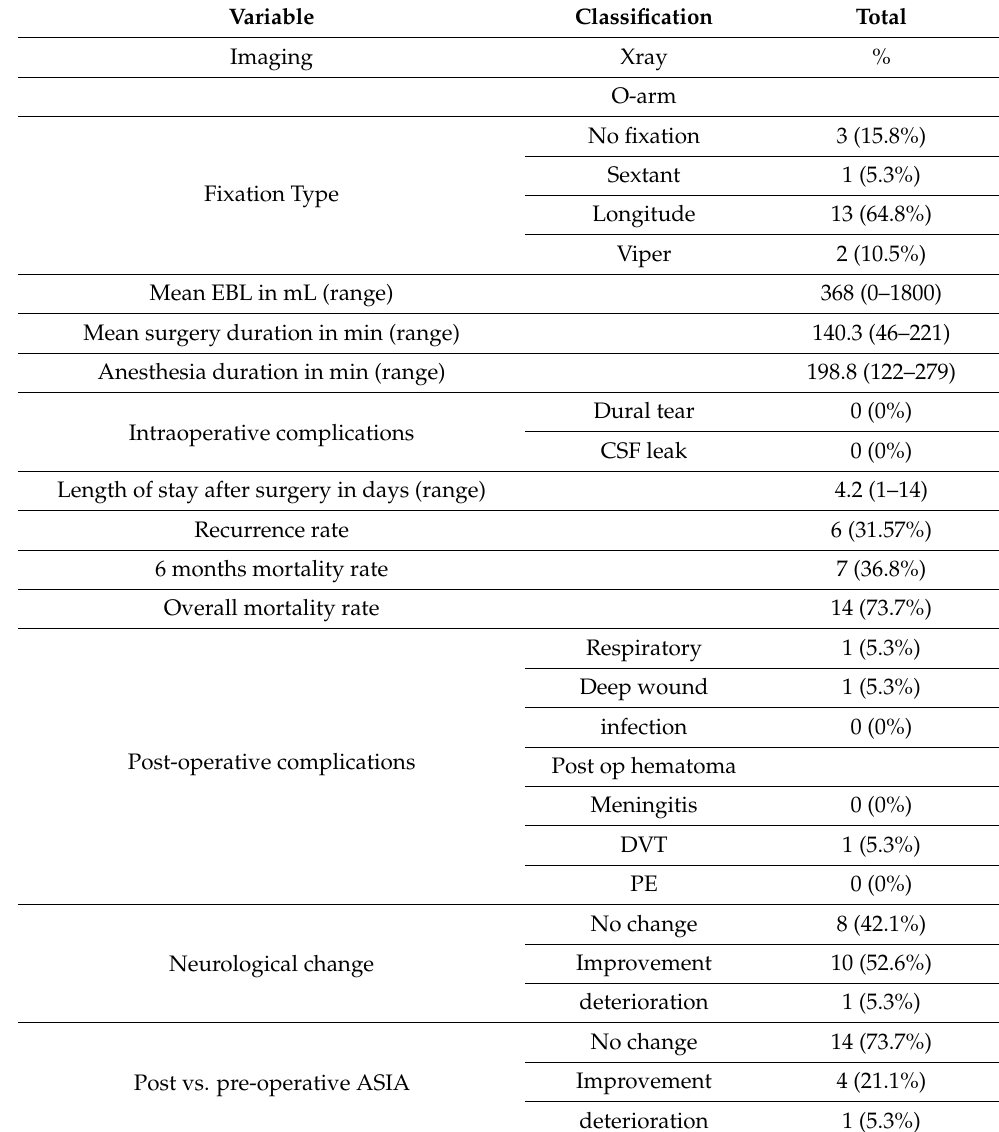
Table 2. Perioperative data in 19 patients with epidural spinal